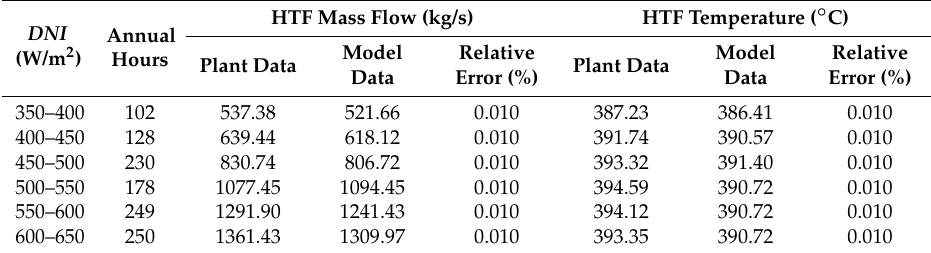
Table 3. Superheater inlet comparative series using a bin hours annual time